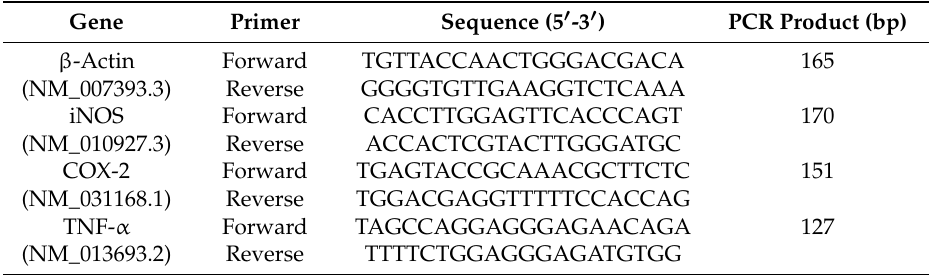
Table 1. Primers used for the quantitative real-time